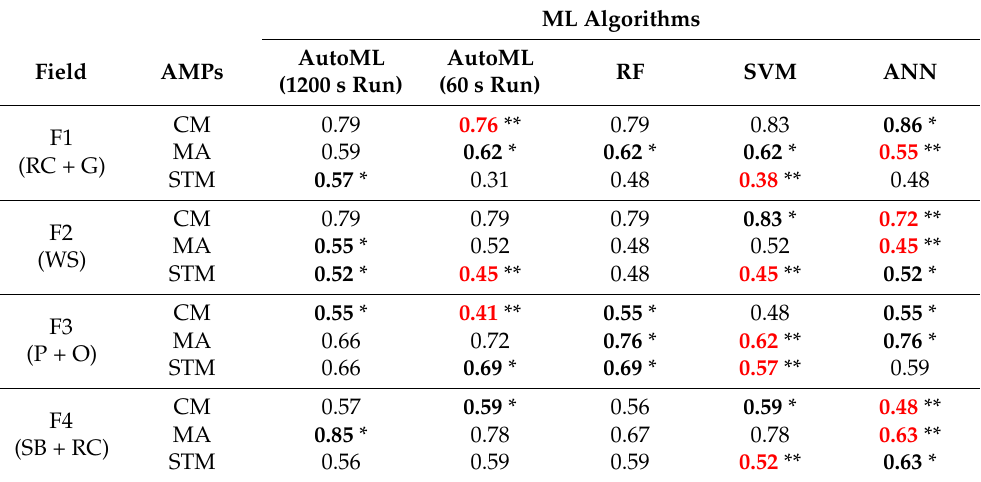
Table 4. The AMPs classification accuracy comparison of AutoML and three other popular applied ML (RF, SYM, and ANN) algorithms in